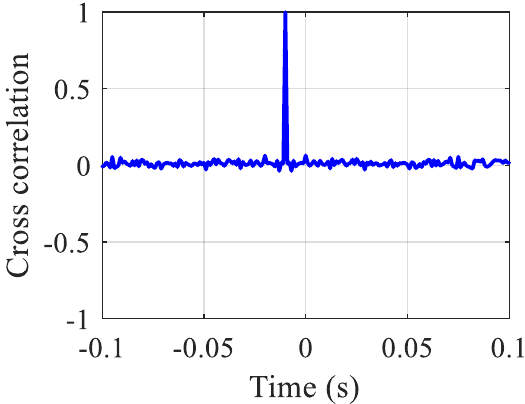
Figure 6. The BCC result of the simulated sensor signals for the pipe with leakage.